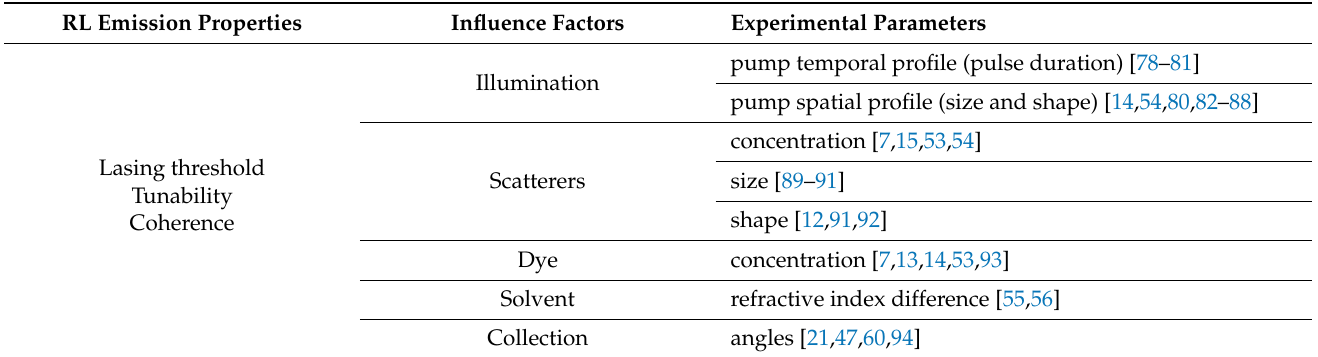
Table 1. Different influence factors of the RL emission